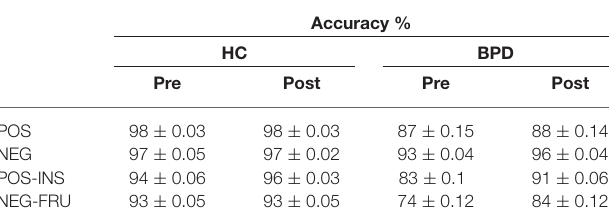
TABLE 3 | AGN task performance pre/post repetitive transcranial magnetic stimulation (rTMS) in HC and BPD groups.